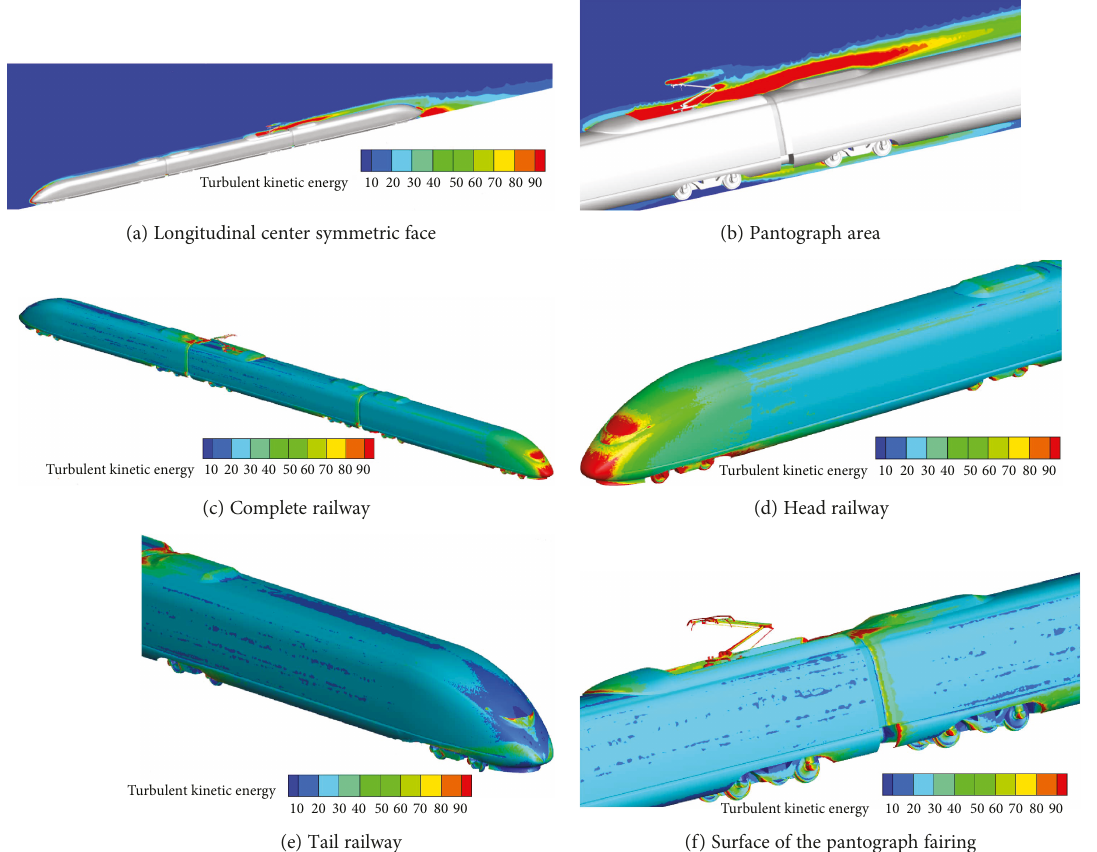
Figure 8: Distribution contour of turbulence energy of high-speed